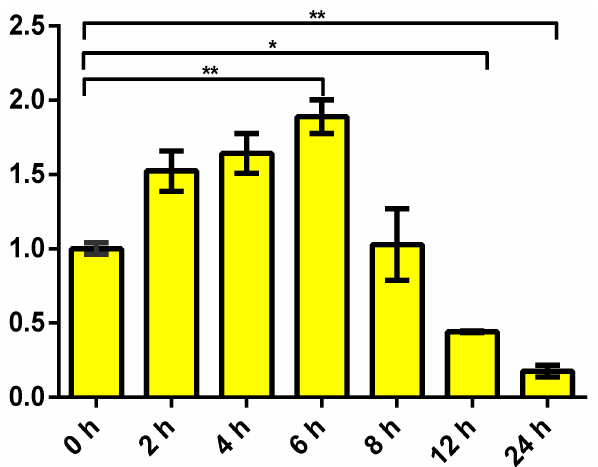
Figure 4. Temporal expression analysis of maNramp mRNA in the spleen after an intraperitoneal injection of E. coli LPS. 18S rRNA gene was used as a reference gene to normalize the expression level. The vertical axis indicated that maNramp mRNA expression is relative to that at 0 h (fold). Significant pairwise expression-level differences between time points were indicated by different asterisks. One asterisks (*) and two asterisks (**) represented p < 0.05 and p < 0.01,